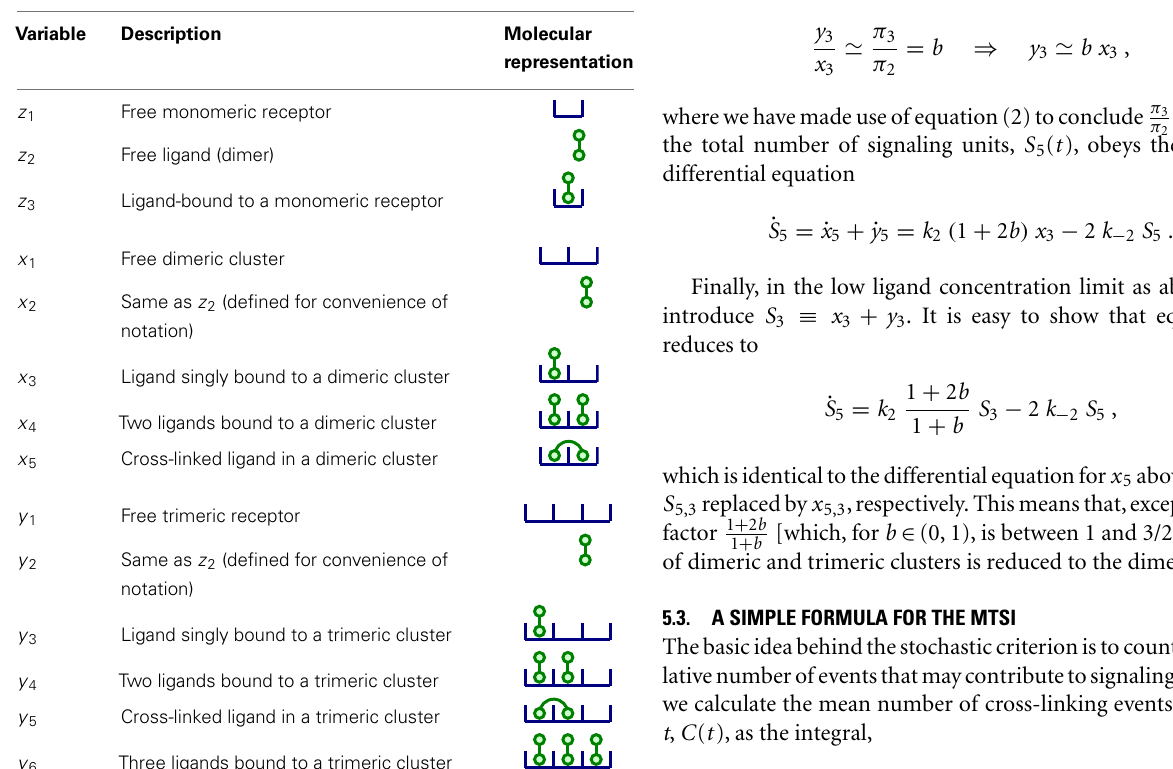
Table 3 | Summary of variables for a model in which clusters of size 1, 2, and 3